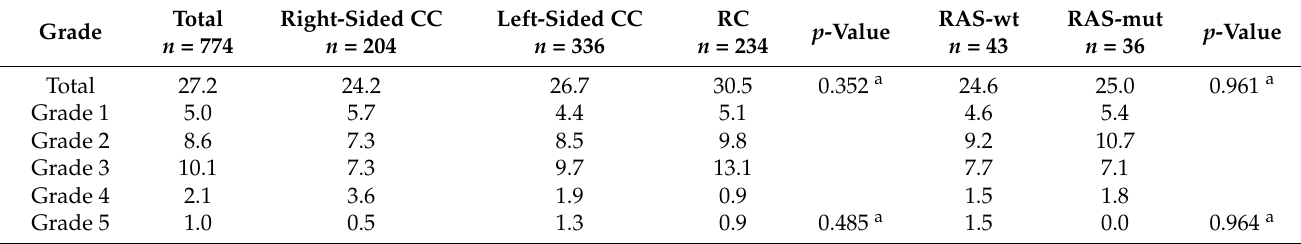
Table 2. Complications of local treatment per primary tumor location and RAS status (CTCAE)